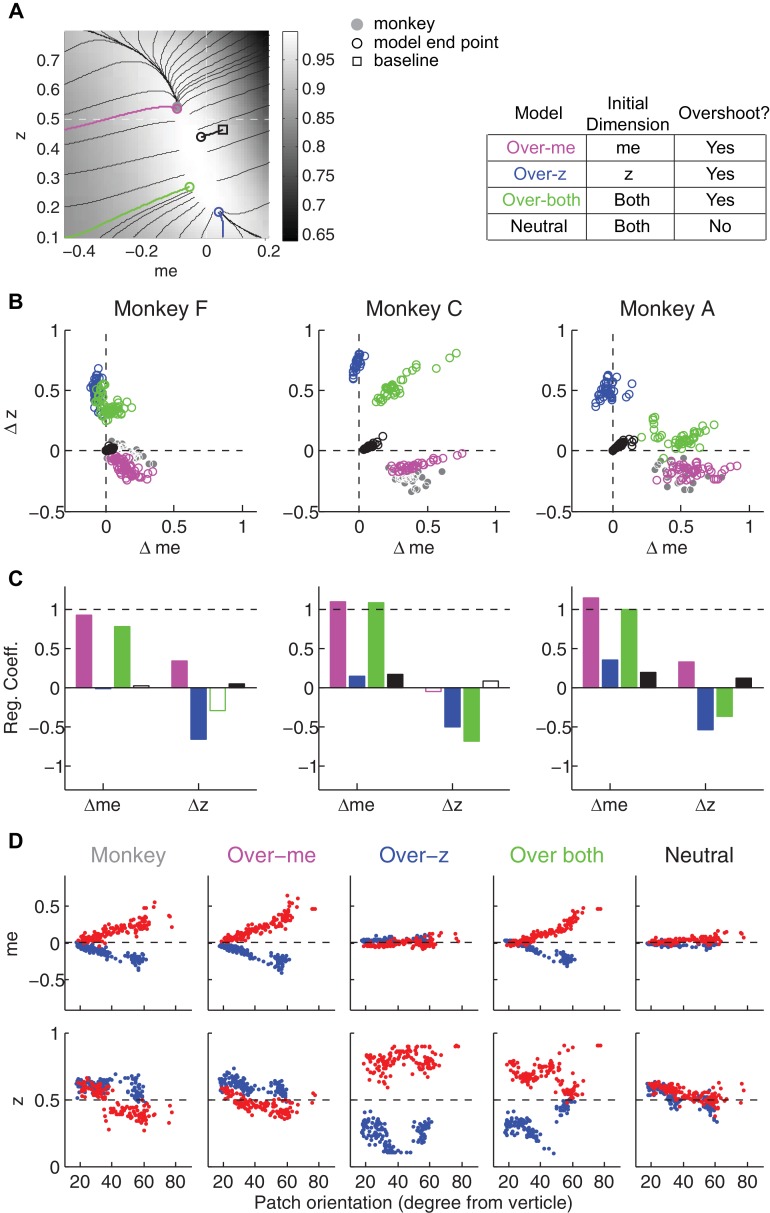
Predictions of a RR gradient-based model.Same format as Figure 8 but using gradients based on RR instead of RTrial. The overly-biased starting me and z values were set as 90% of highest coherence level, and 0.1, respectively, except for the over-both model for one monkey C session (me = 88% * max(coh), z = 0.11) to avoid a local peak in the RR surface. Such local peaks at overly biased me and z values can divert the gradient-based updating process to even more biased values without ever reaching the monkey's final RR (e.g., the green trace at the bottom left corner in monkey C's LR-Left data in Figure 7—figure supplement 1).